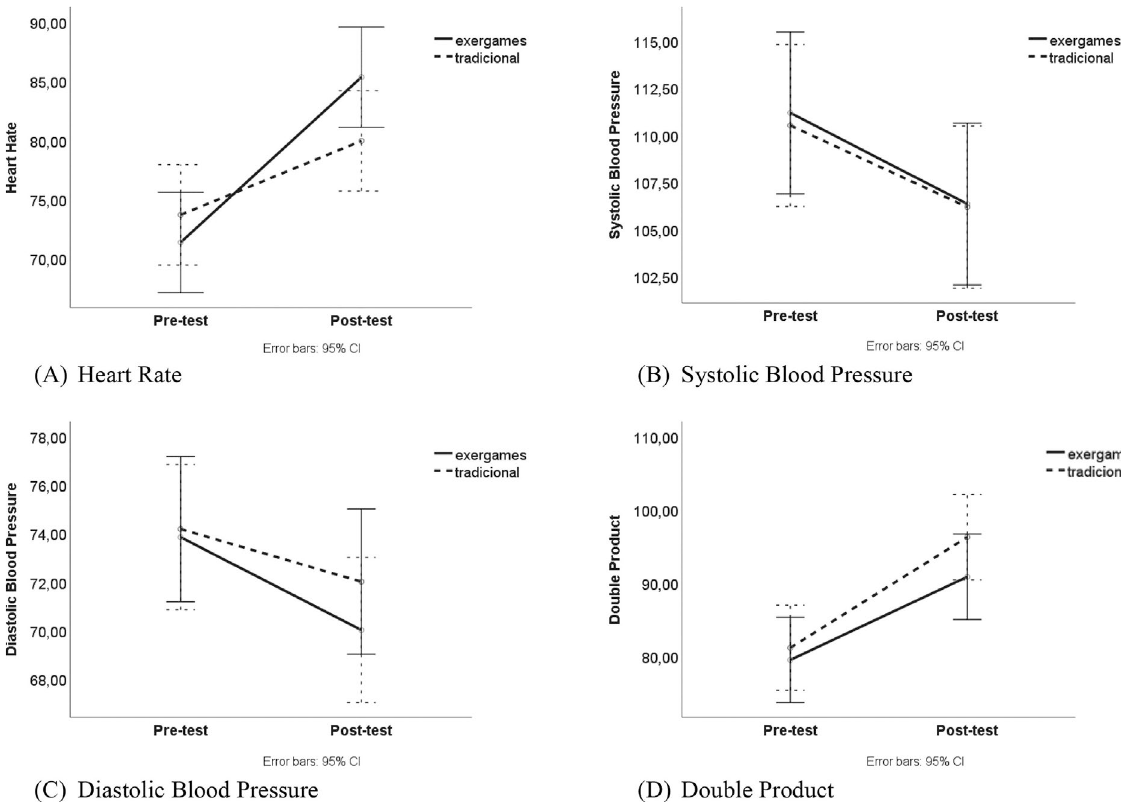
Figure 1 - Mean for dependent variables by exercise condition in the pre and